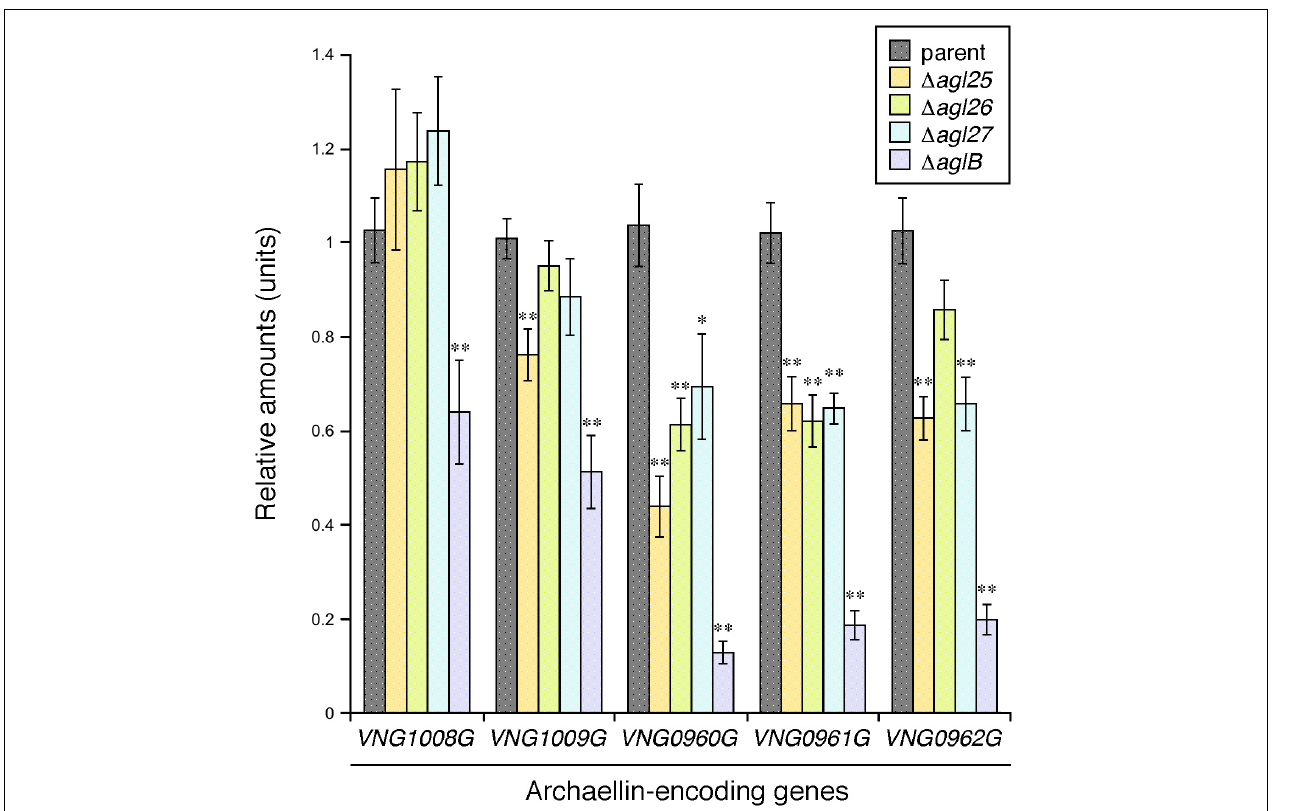
FIGURE 5 | The transcription of genes encoding FlaB1, FlaB2, and FlaB3 is reduced in cells lacking Agl25, Agl26 or Agl27. The levels of cDNA, reverse-transcribed from mRNA isolated from parent, (cid:49) aglB, (cid:49) agl25 , (cid:49) agl26 , and (cid:49) agl27 strain cells, were quantified by qRT-PCR using primers against VNG1008G , VNG1009G , VNG0960G , VNG0961G , and VNG0962 ( Table 1 ). Transcript levels of each gene were normalized to that of a housekeeping gene ( VNG0657G ) in the parent strain and corresponding deletion strain. The transcript levels of VNG1008G , VNG1009G , VNG0960G , VNG0961G , and VNG0962 were then normalized to the levels measured in the parent strain. The values presented represent the average of triplicate repeats of four biological repeats ± SEM. ∗ Statistically significant (Student’s t test) relative to the parent strain > 95%. ∗∗ Statistically significant relative to the parent strain > 99%.